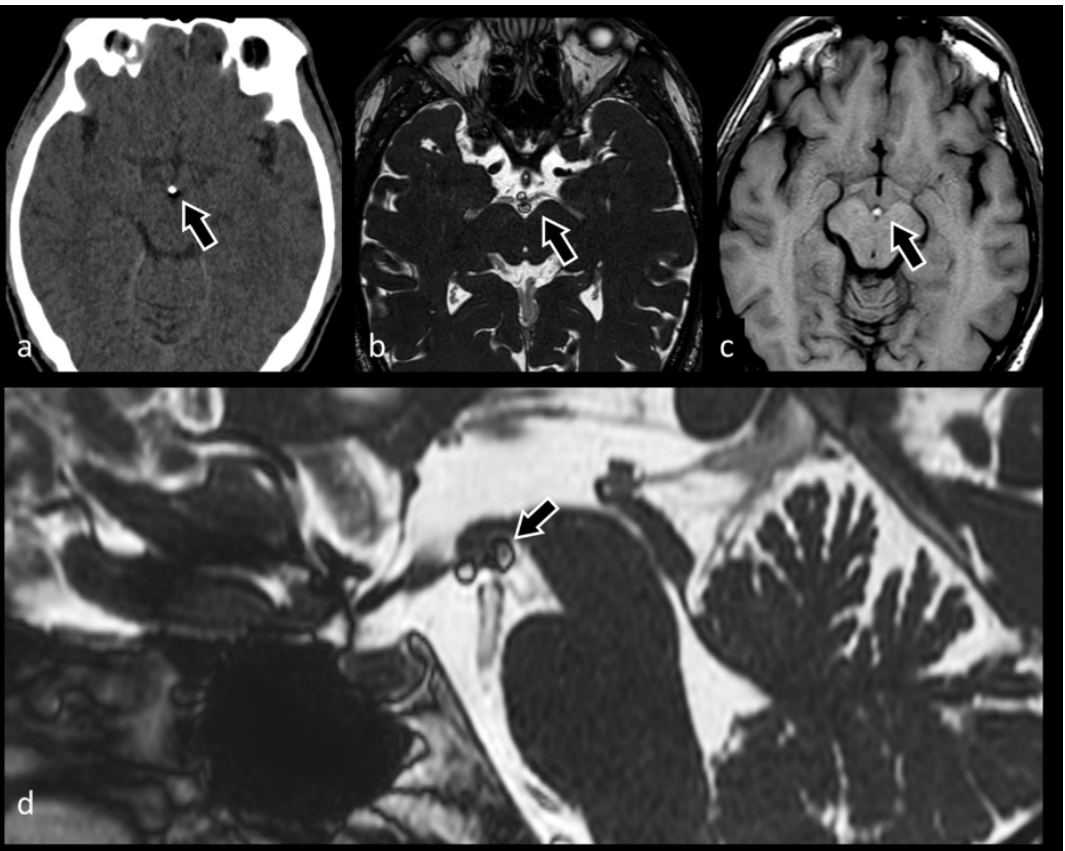
Figure 9. Axial brain CT ( a ) shows two incidentally-discovered focal calcified formations (arrow) located in the interpeduncular cistern, indissociable from the basilar artery. Axial and sagittal 3D CISS images ( b , d ) characterize the formations (arrow) and their relationship with the basilar artery well, and show the calcifications are mainly located at the periphery of the lesions, appearing as subtle hypointense rims. MRI also reveals the lesions (arrow) present a lipidic core, which appears hyperintense on spin-echo T1-w. sequence ( c ) and shows signal dropout on fat-suppressed images (not shown). Findings were consistent with osteolipomas.